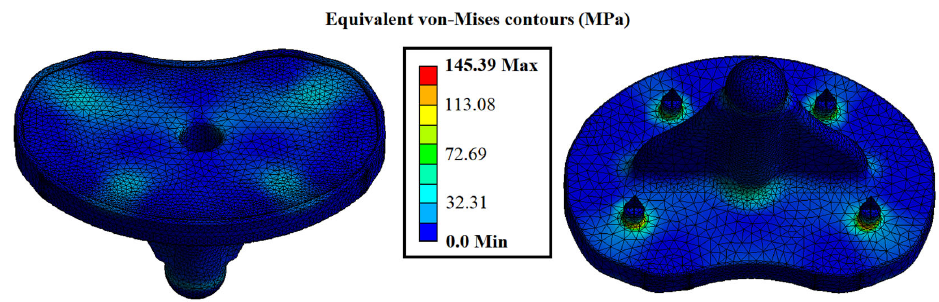
Figure 5. Contours of the initial design of the tibial implant for equivalent von Mises stress.